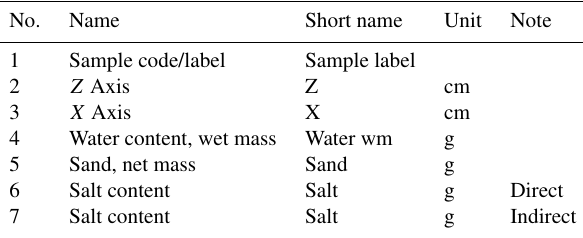
Table 5. Structure of the subsurface salinity profile data sets at PANGEA (Lasser and Goehring, 2020a). The data contain sample labels; the vertical (Z) and horizontal (X) position of each sample along the survey; and the masses of water, sand, and salt (measured by two methods) in those samples. See Sect. 2.2.3 for details of analysis